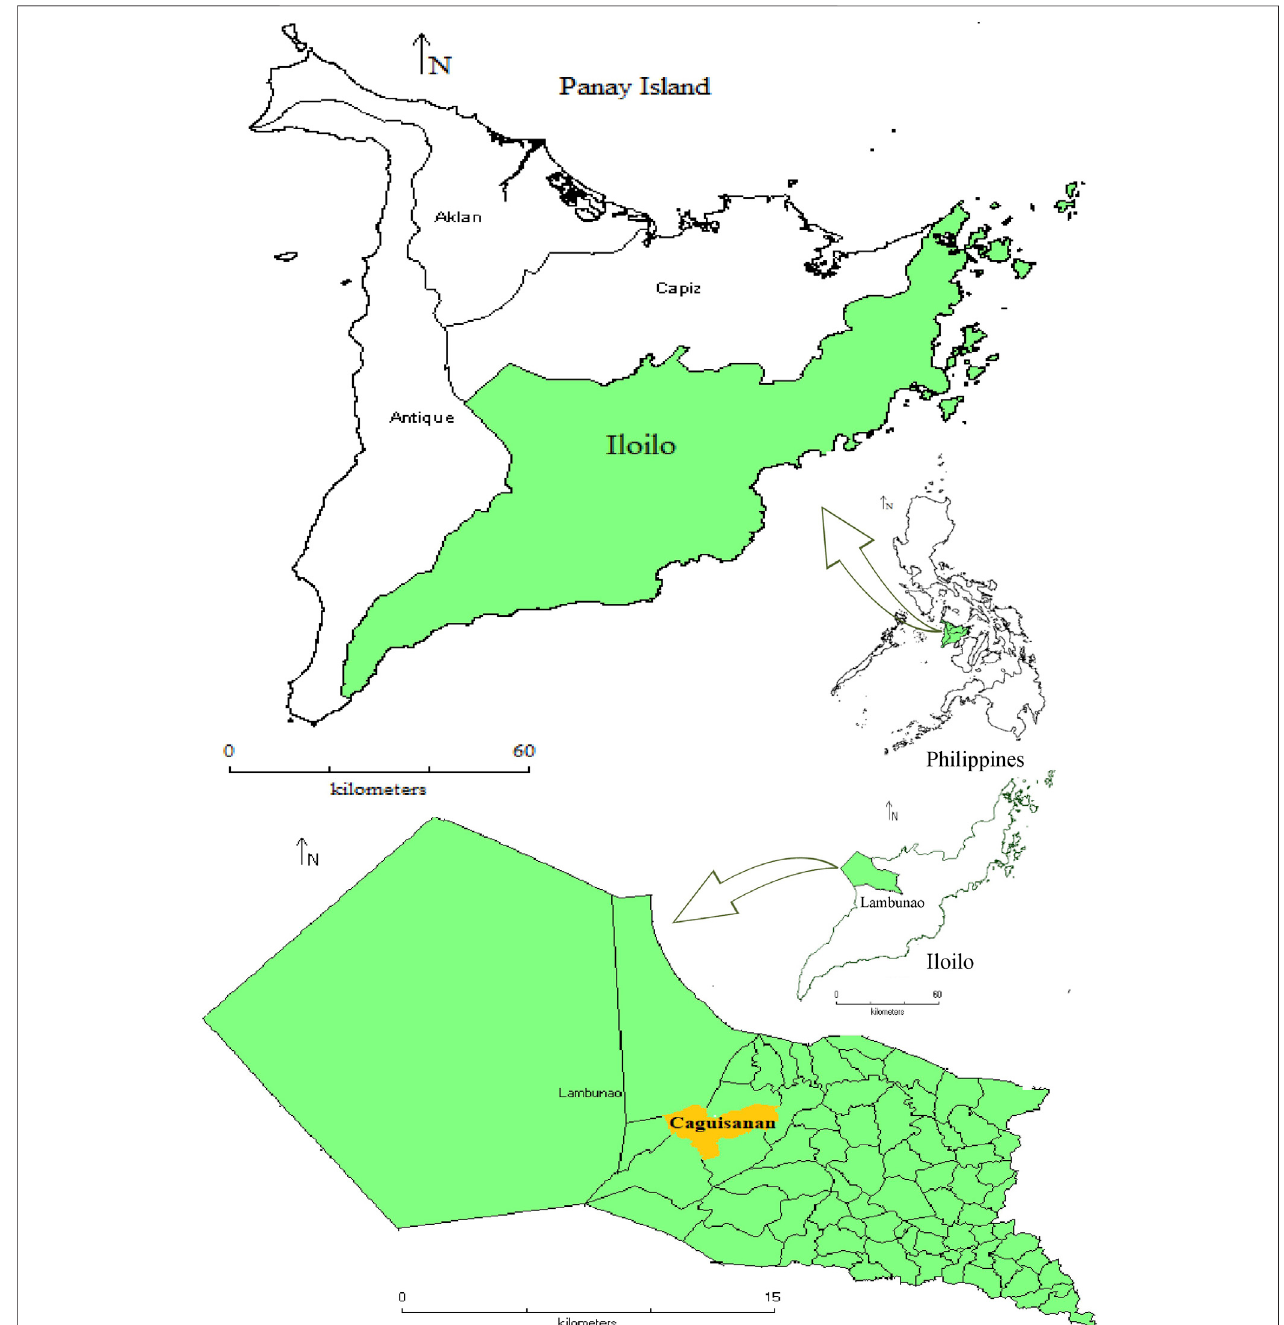
FIGURE 1 | Position of the study area in Panay Island